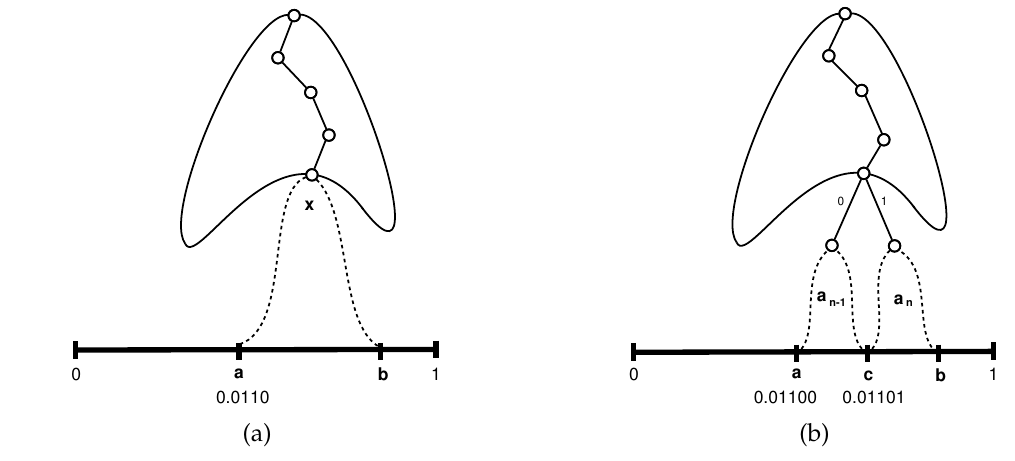
Figure 2. Schematic view of the inductive step of the